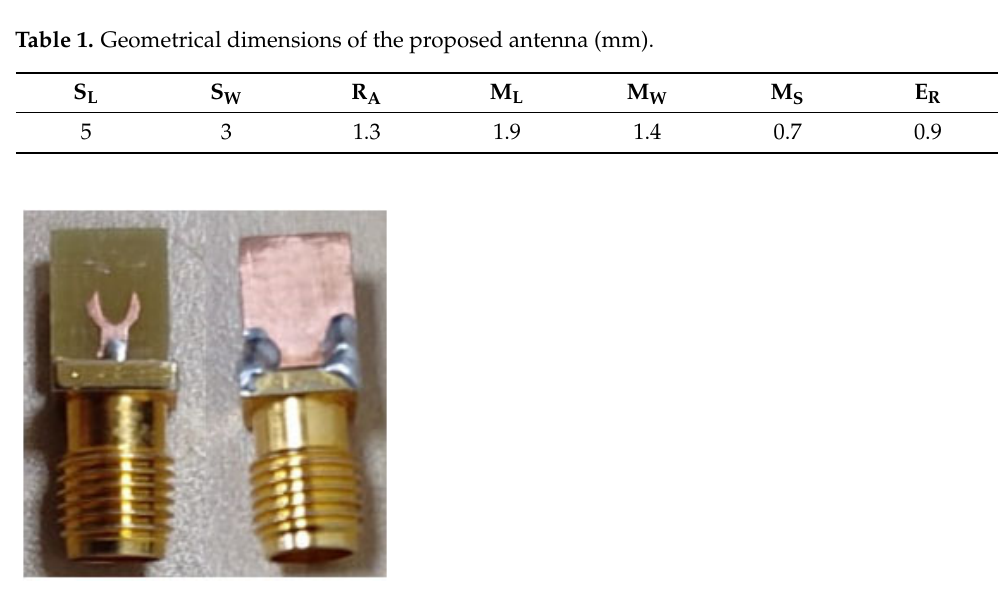
Figure 2. The prototype of the projected antenna design depicts the front and ground plane.